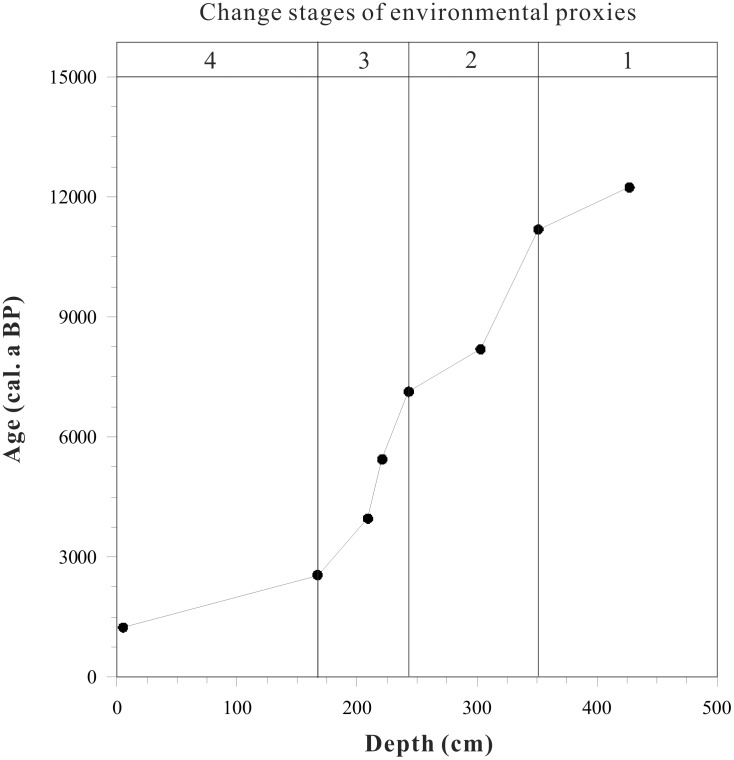
Age-depth curve and sedimentation rate for Xingyun lake core. Radiocarbon dates are listed in Table 1.